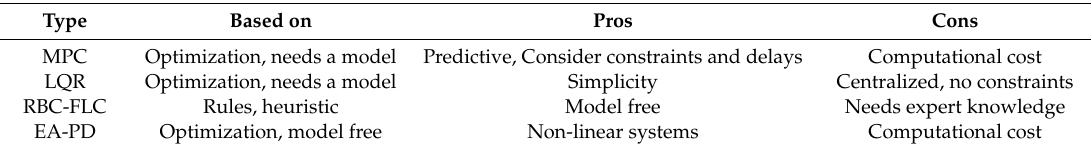
Table 1. Some features of real-time control